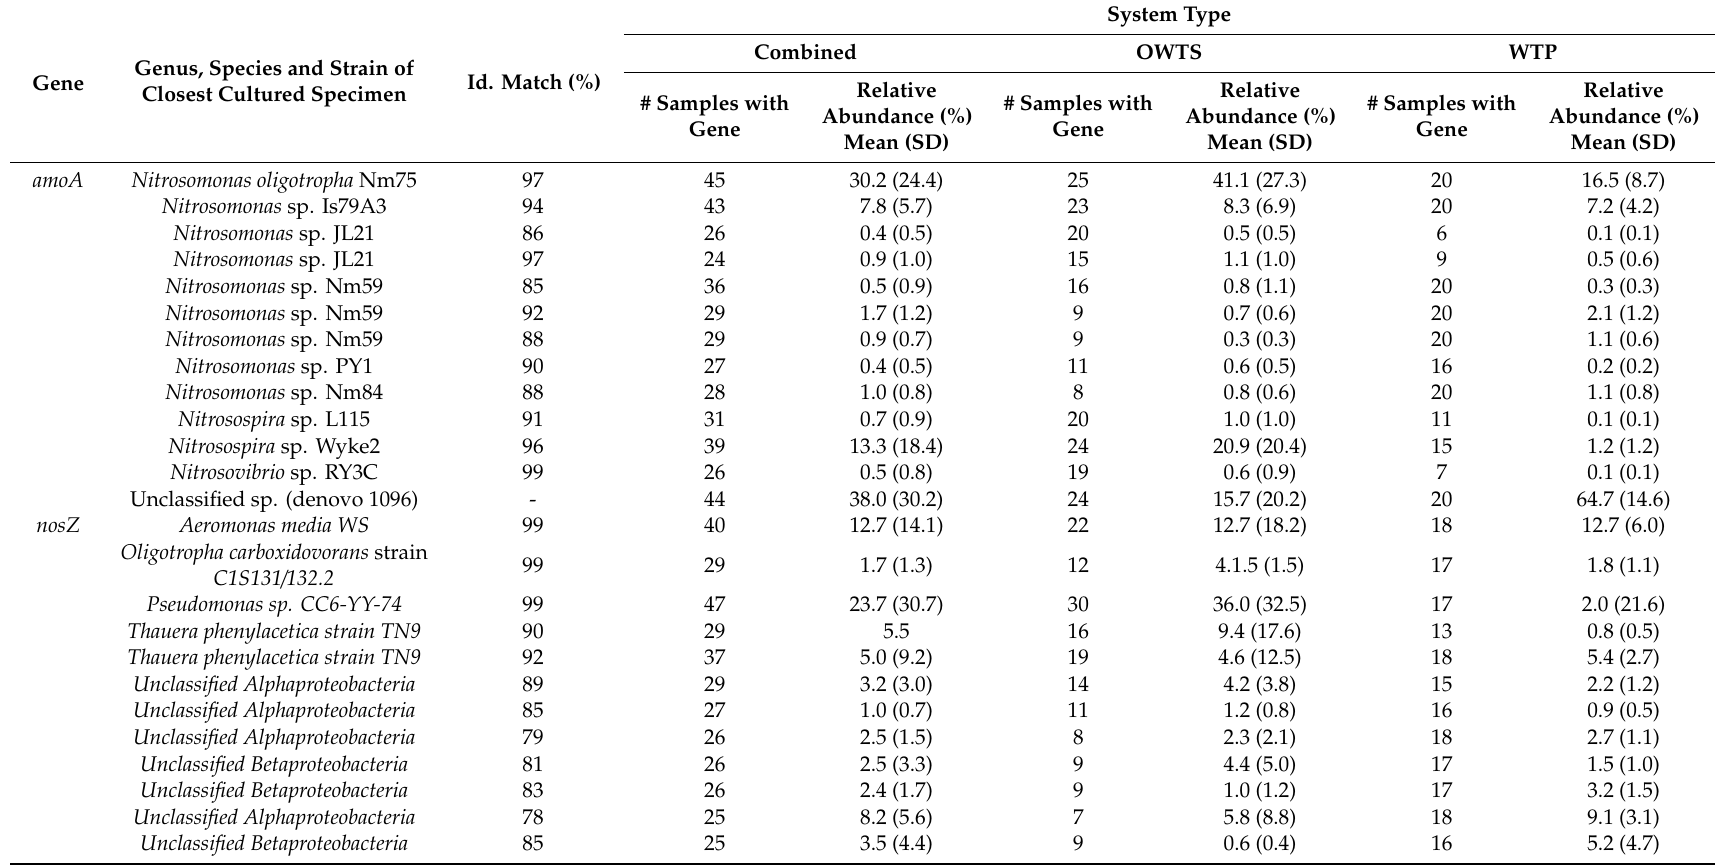
Table 1. Species present in at least 50% of samples. Genus, species, and strain of closest culture specimen based on sequencing of nosZ and amoA in onsite wastewater treatment systems (OWTS) and a wastewater treatment plant (WTP) with biological nitrogen removal (BNR). The total number of samples analyzed for amoA was 25 for OWTS and 20 for WTP. The total number of samples analyzed for nosZ was 36 for OWTS and 18 for WTP. Data from June and October 2016 samples were combined for this